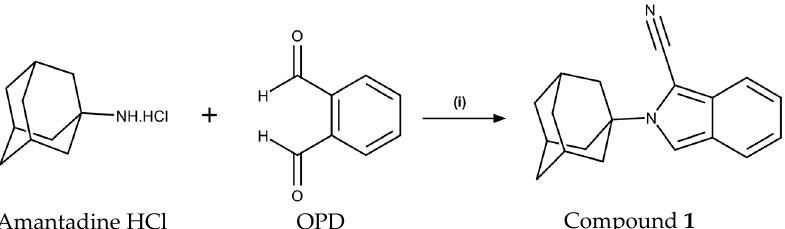
Figure 1. The asymmetric unit of compound 1 showing the atomic numbering scheme and 30% probability displacement ellipsoids of non-H atoms.